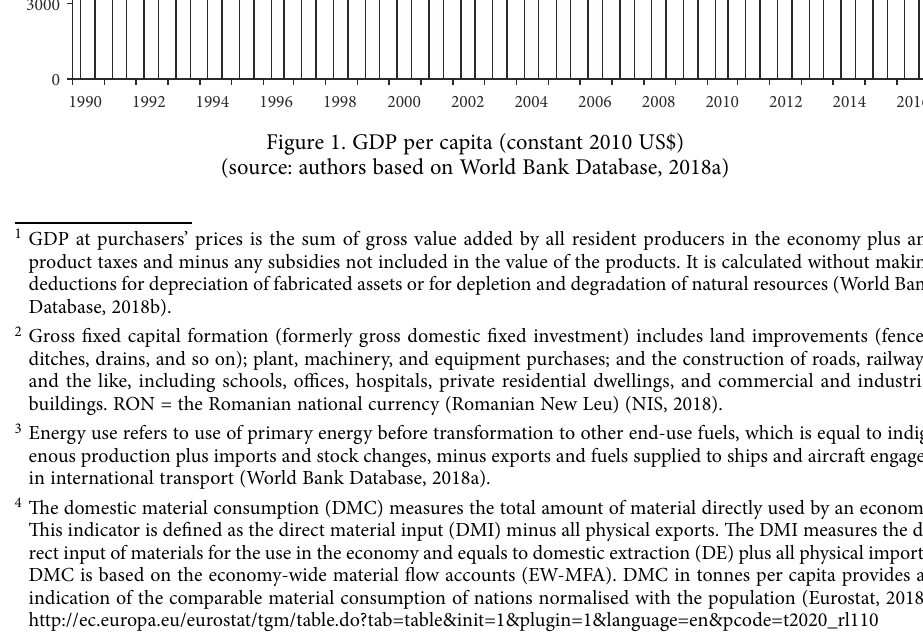
y = 225.35 x + 3453.8 R 2 =